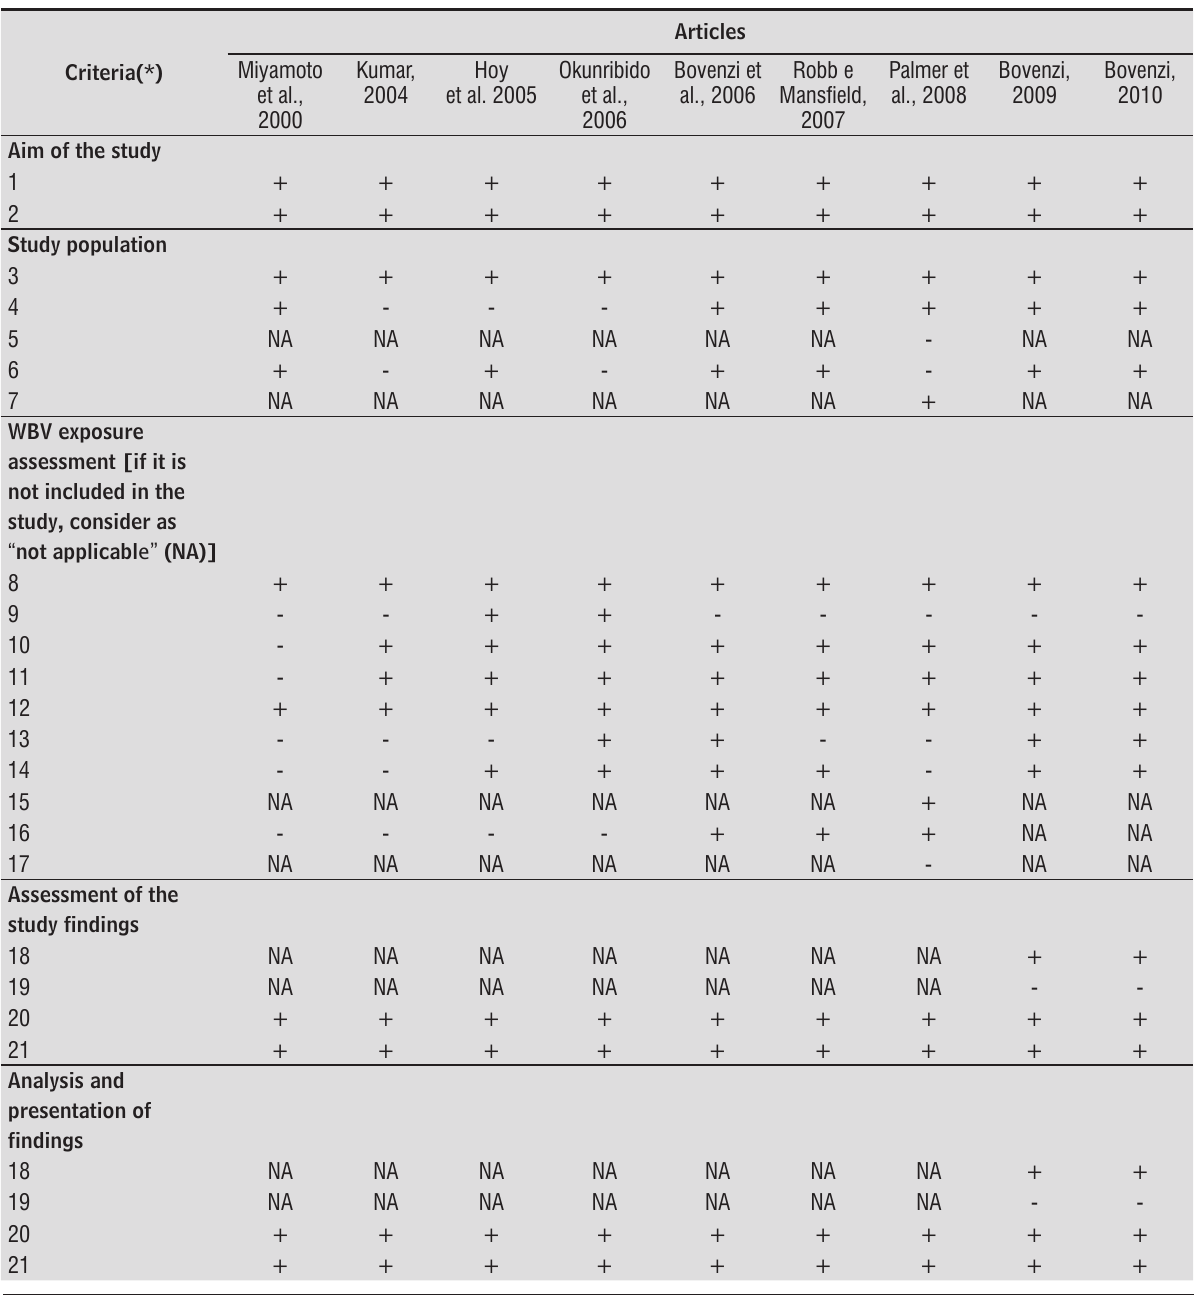
Table 2 - Standardized checklist of methodological quality of the cross-sectional (CS), case-control (CC) and cohort